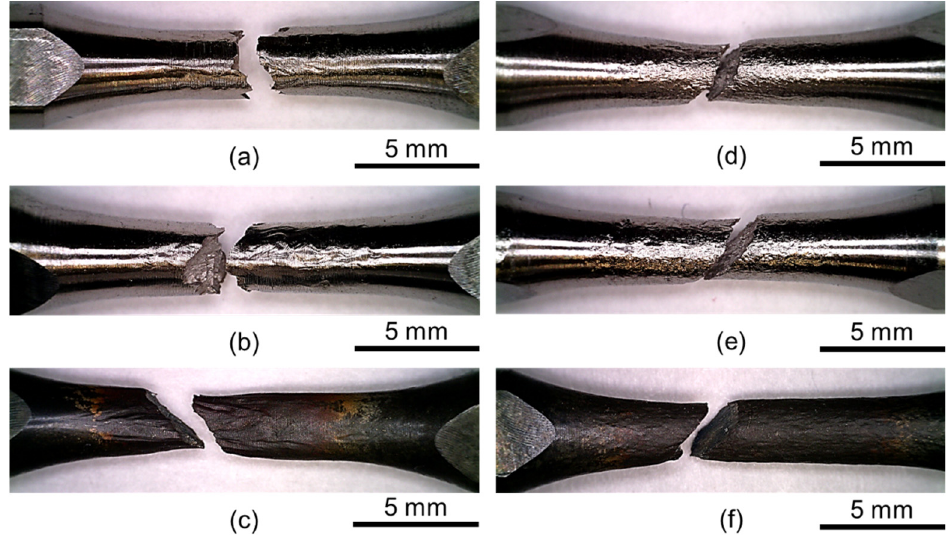
Figure 10. Longitudinal view of the fractured specimens: ( a ) DA specimen tested in quasi-static condition at room temperature; ( b ) DA specimen tested in high strain rate condition at room tem- perature; ( c ) DA specimen tested in high strain rate condition at 1000 °C; ( d ) HT specimen tested in quasi-static condition at room temperature; ( e ) HT specimen tested in high strain rate condition at room temperature; ( f ) HT specimen tested in high strain rate condition at 1000 °C.